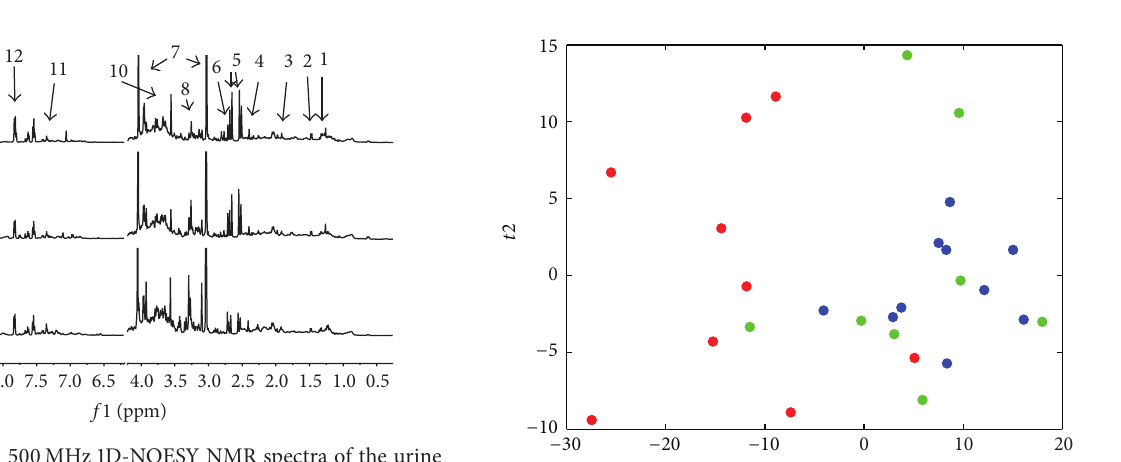
Figure 2: Typical 500 MHz 1D-NOESY NMR spectra of the urine sample from an athlete. (1) Lactate (d, 1.32 ppm); (2) alanine (d,